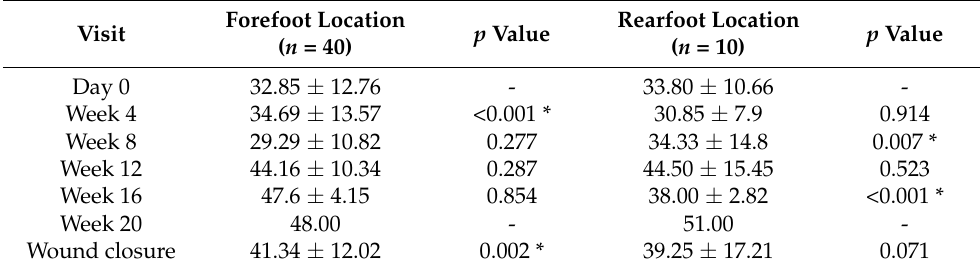
Table 4. Differences in tcpO 2 values in the feet of patients after sucrose octasulfate dressing applica- tion depending on DFU location (forefoot and rearfoot). Forefoot Location p Visit